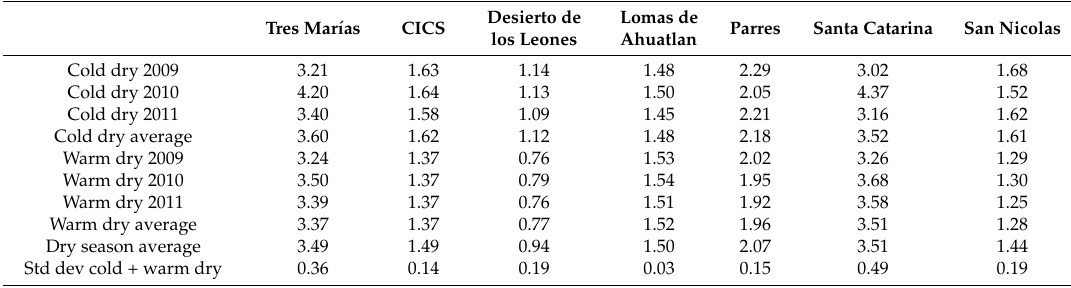
Table 2. Empirical correction factors for x = c o / c m showing that MCCM systematically underestimates O 3 in the rural sites sampled using passive monitors, with X = 2.06 ± 1.0. Desierto de Lomas de Tres Mar í as CICS los Leones Ahuatlan